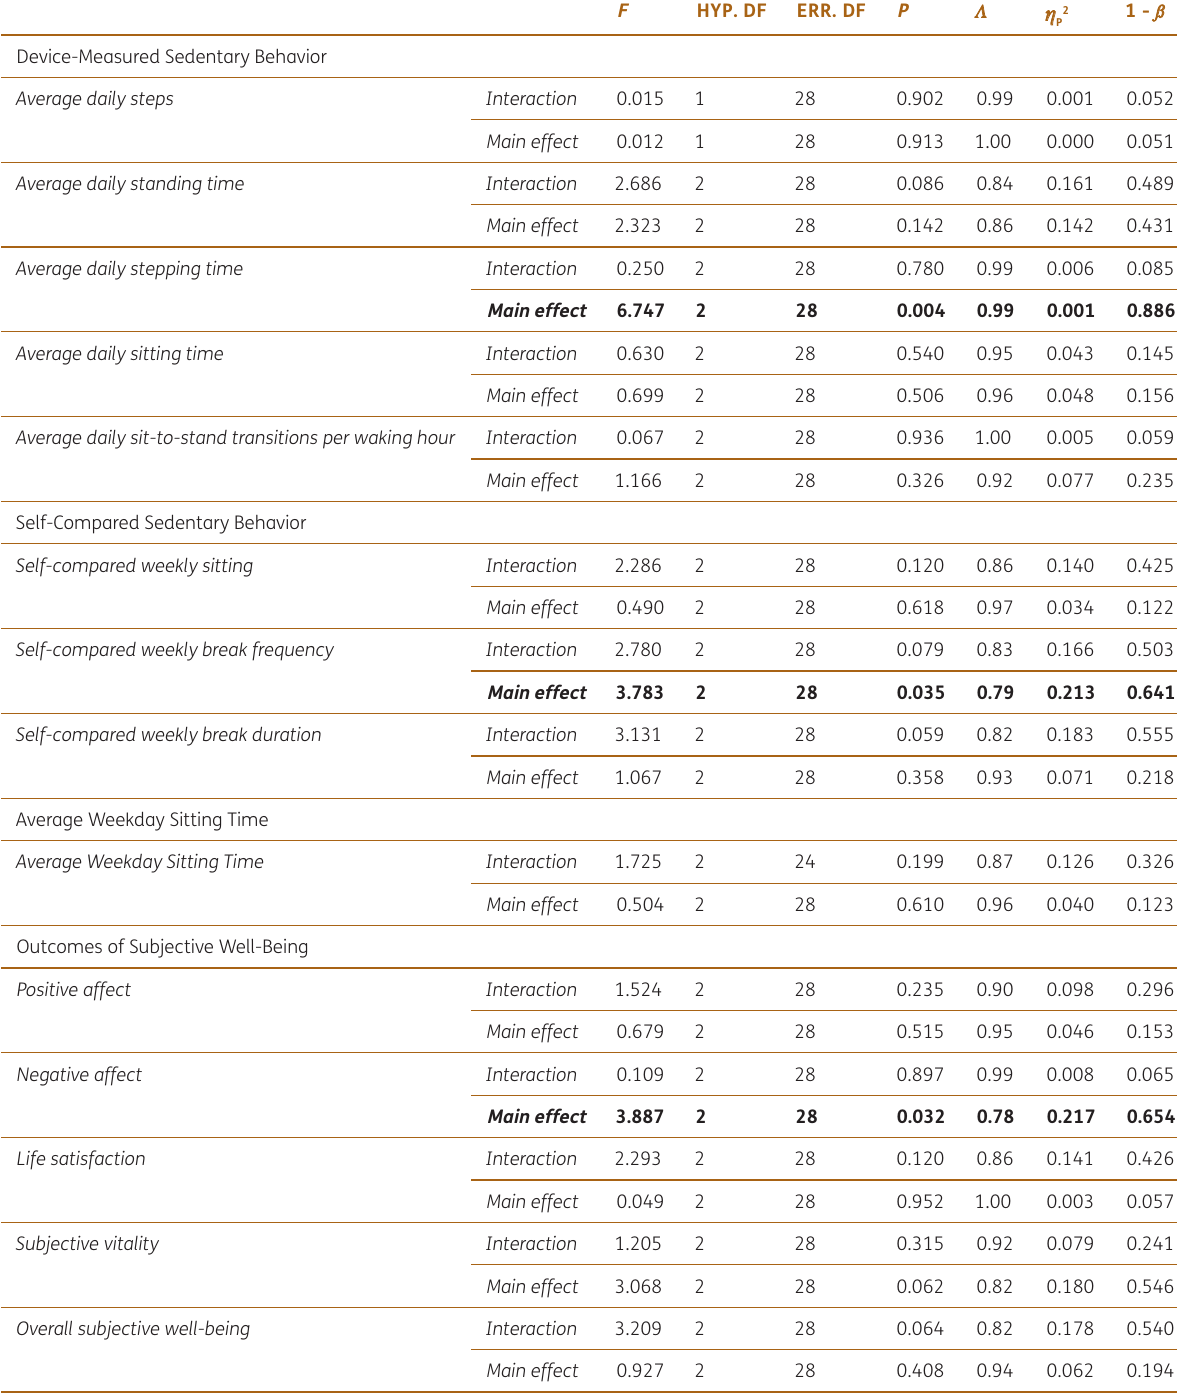
Table 5 Repeated-measures interaction effects and main effects of time for device-measured, self-compared, and average weekday sedentary behavior outcomes and outcomes of subjective